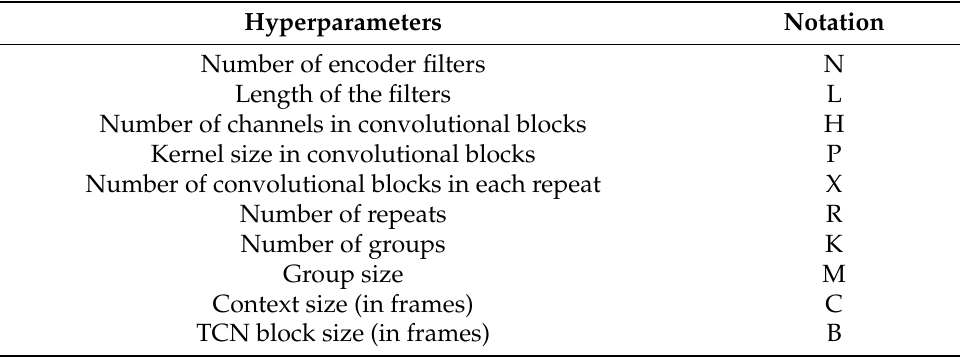
Table 1. Hyperparameters and notations used in GC3-TCN.